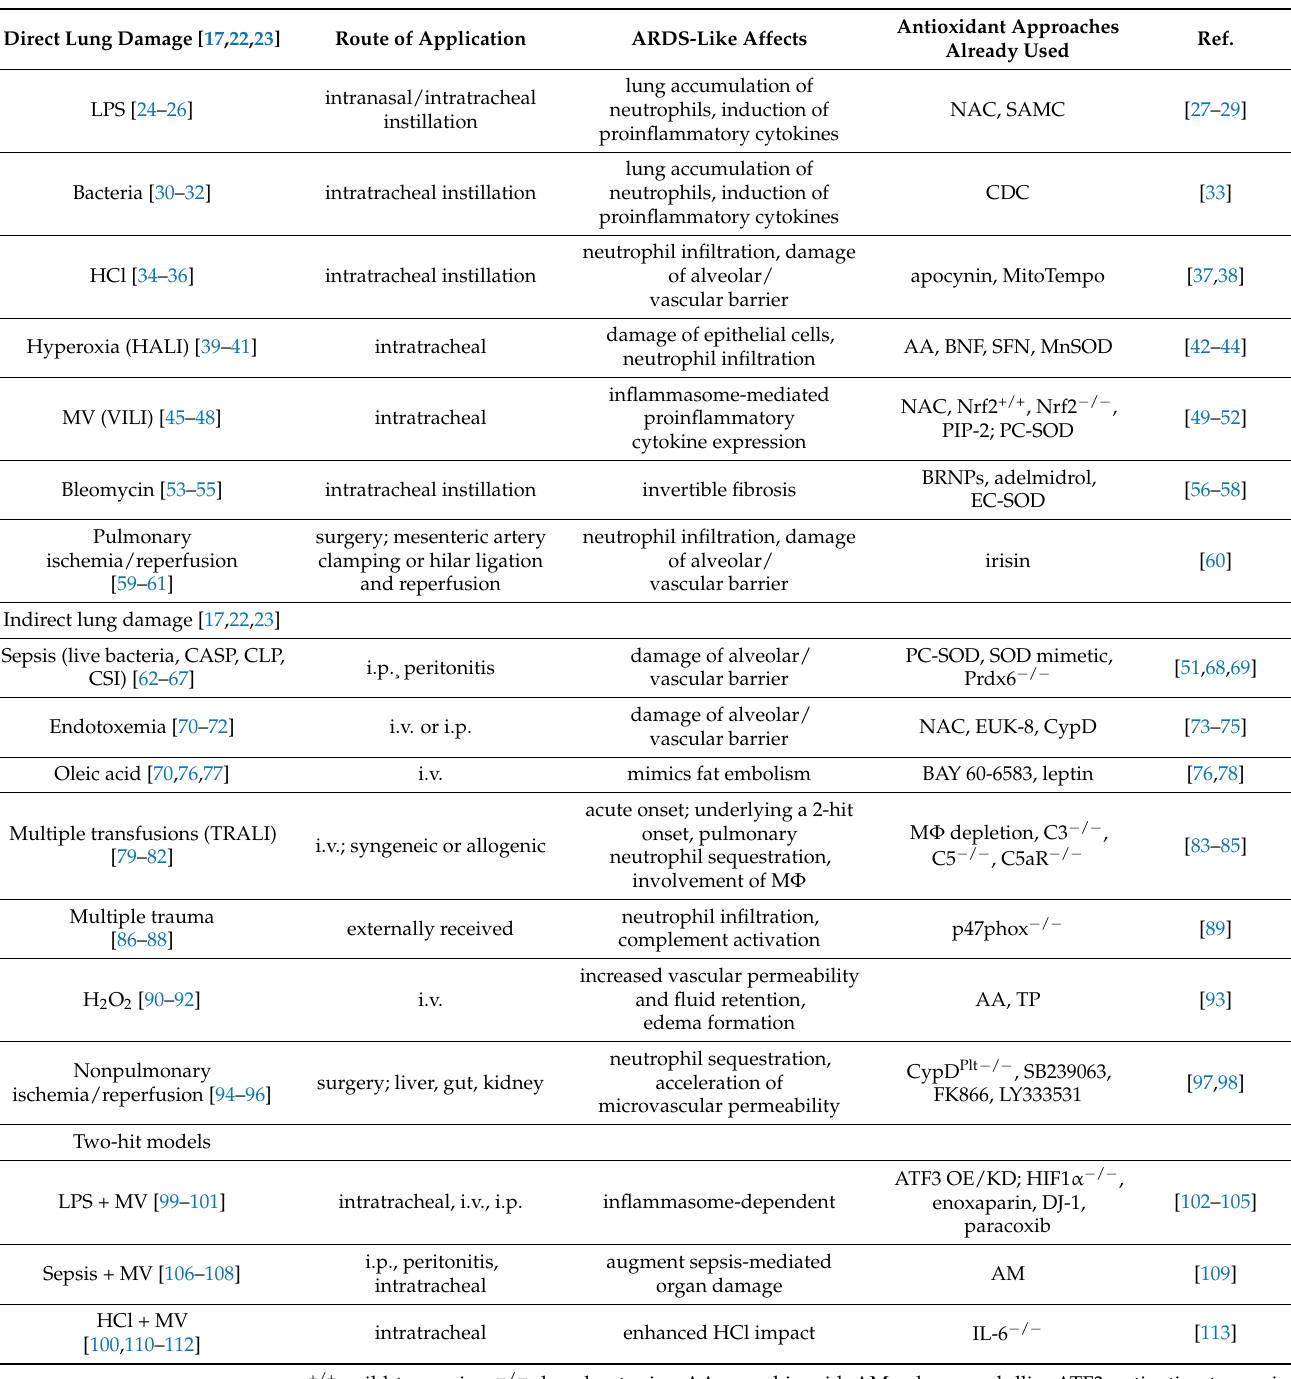
Table 1. Mouse models in ARDS